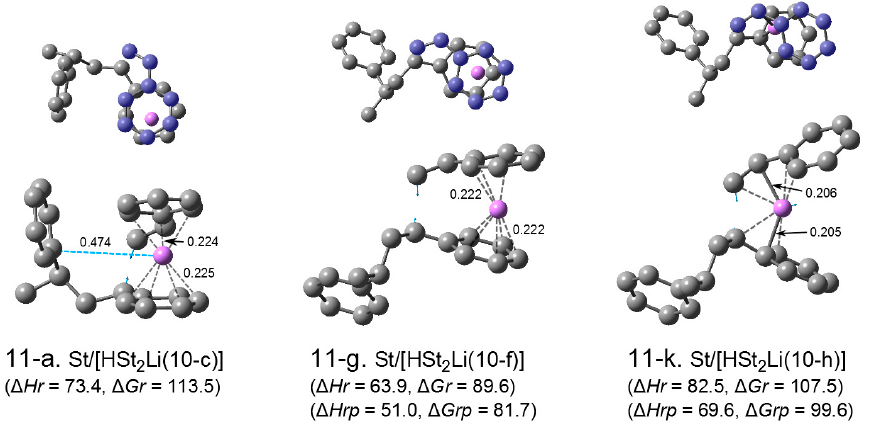
Figure 11. Representative transition states for the addition of styrene to HSt 2 Li with and without the penultimate unit coordination in the gas phase. In the lower drawings the shortest distances between Li and the chain-end-unit carbon, between Li and styrene carbon, and between Li and the penultimate-unit carbon for (11-a) are shown. ∆ Hr and ∆ Gr , the relative enthalpy and relative free energy, are expressed in kJ·mol –1 . ∆ Hrp and ∆ Grp in the lower parentheses of (11-g) and (11-k) are the enthalpy and free energy with respect to (St + 1/2[(HSt 2 Li) 2 (9-f)]), in kJ·mol –1 . Hydrogen atoms are not shown. The other drawing details as in Figure 4-1.